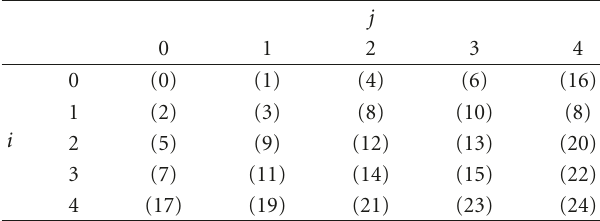
( m , n ) of size 5 × i , j